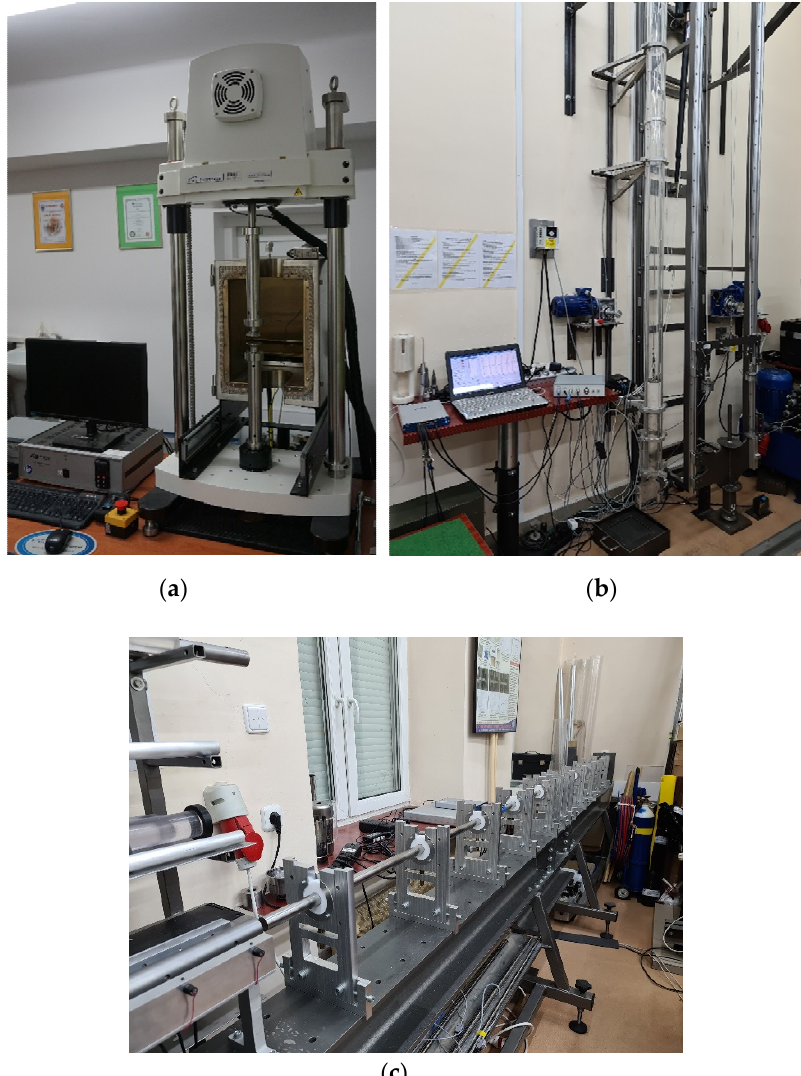
Figure 4. Test equipment: ( a ) ElectroForce 3330 Series II Axial, ( b ) impact hammer, and ( c ) Split Hopkinson’s Pressure Bar (SHPB).